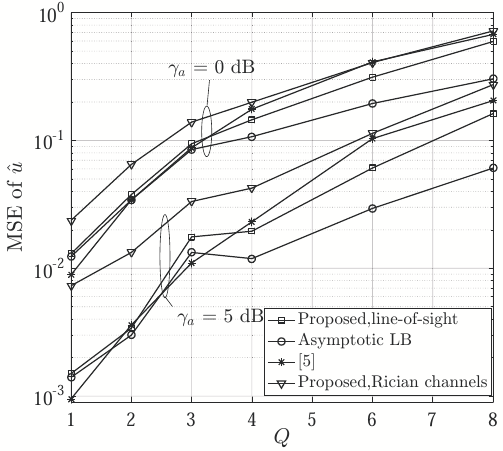
Figure 5. MSE of ˆ u versus Q , ( N = 24 and T =